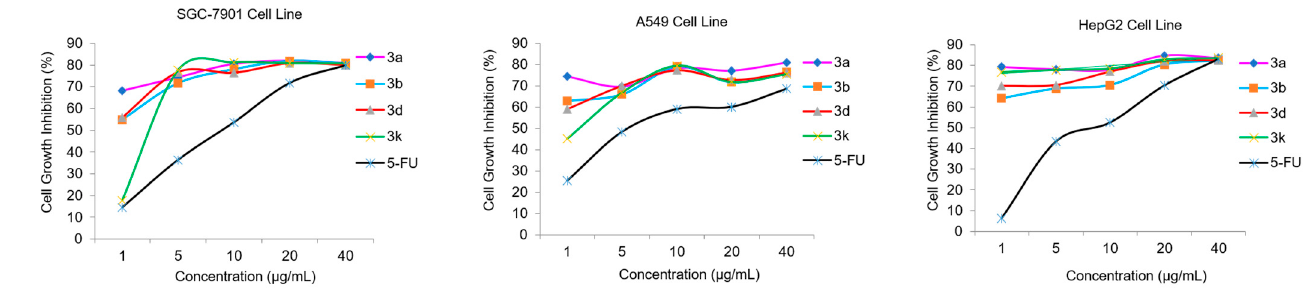
Figure 4. Dose-response analysis of cell growth inhibition activity for the potential compounds 3a , 3b , 3d , 3k, and 5-FU (positive control) against SGC-7901, A549, and HepG2 cell lines.